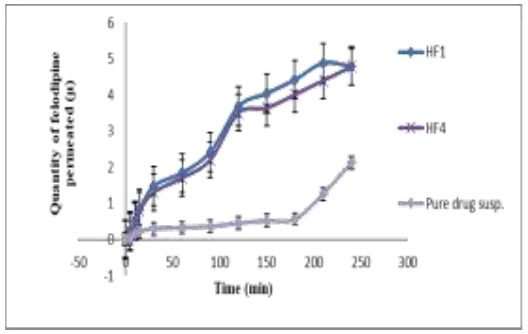
Figure 7. Permeation of felodipine from LPHNs formulations HF1, HF4 and pure drug suspension through non-everted sheep intestine, the values of mean ±SD (n=3).